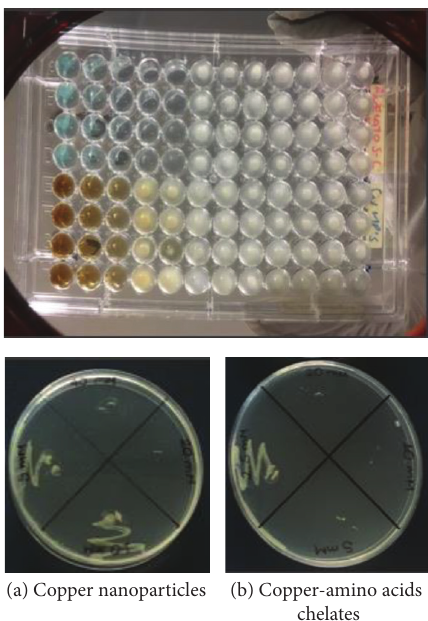
Figure 7: MICs of nanoparticles against bacterial strain Entero- coccus faecalis . (a) Copper nanoparticles; (b) copper-amino acids chelate.